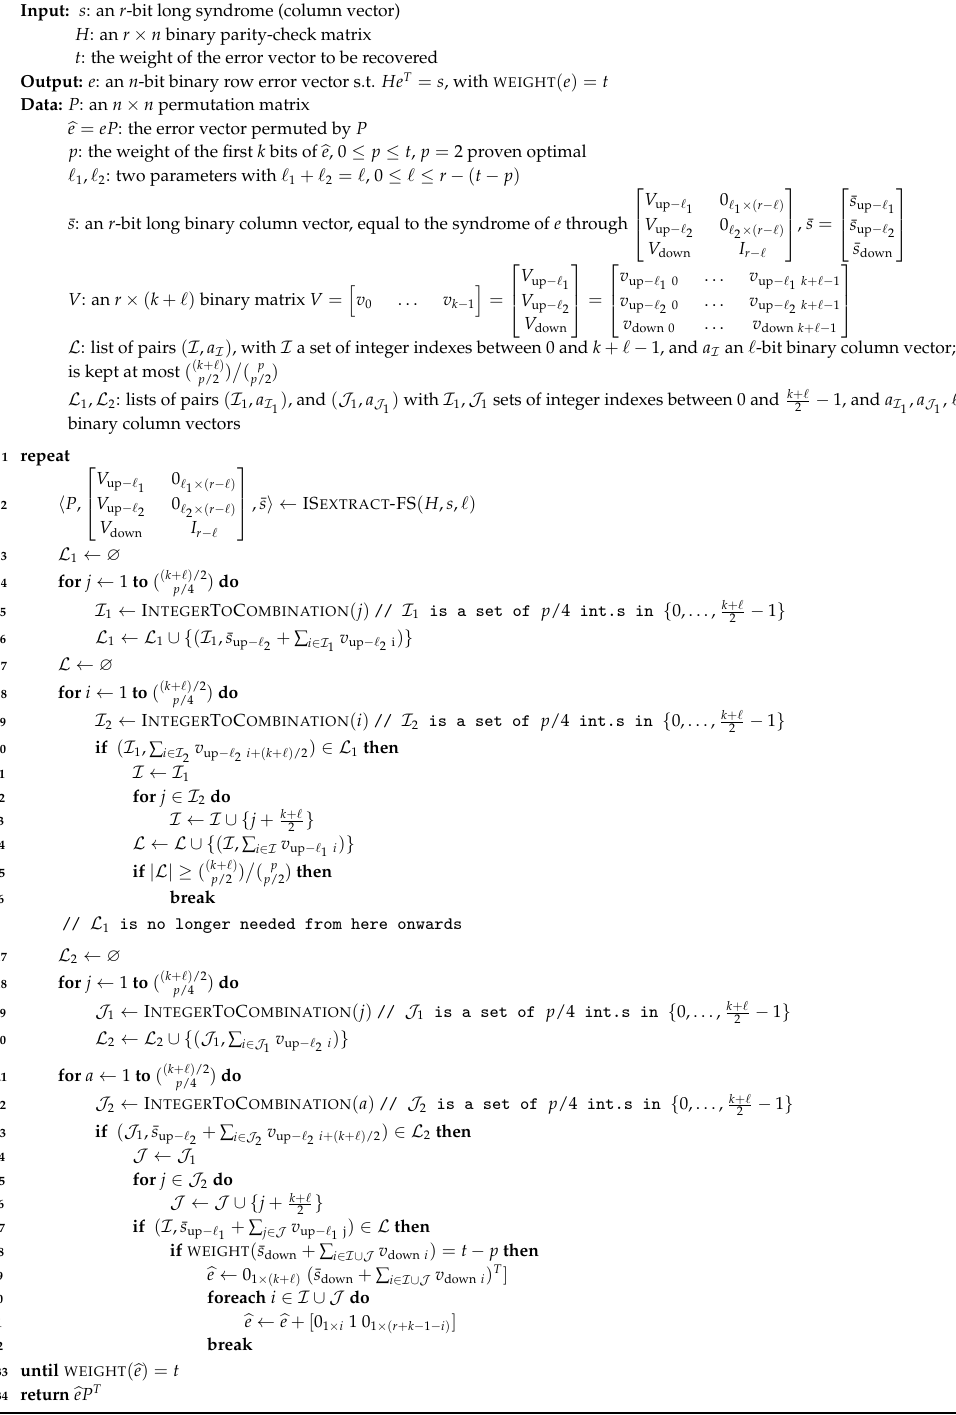
Algorithm 7: Syndrome decoding formulation of May–Meurer–Thomae